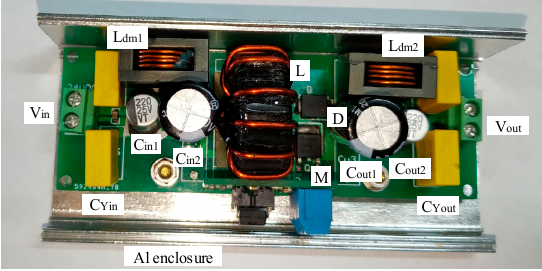
Figure 2. The front photo of the boost converter.